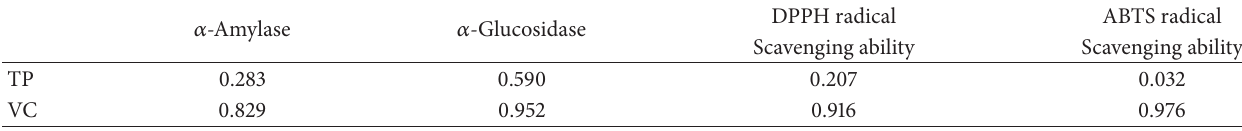
Table 3: Pearson correlation coefficients for total phenol, vitamin C contents, amylase and glucosidase inhibitory, and free radical (DPPH and ABTS) scavenging abilities of the banana